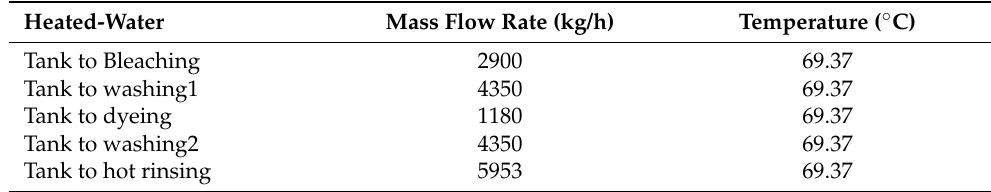
Table 4. Flow rate and temperature of heated-water (Case